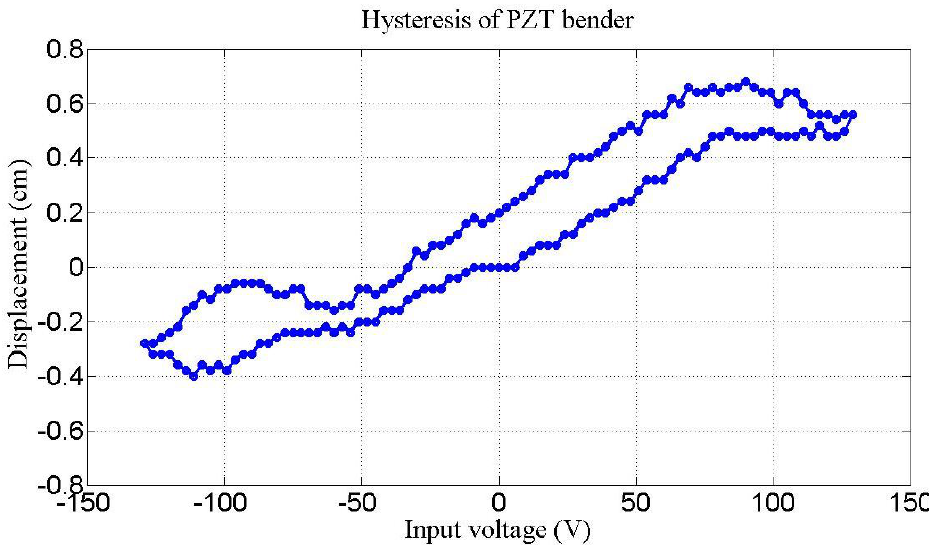
Figure 9. Deflection curve of hysteresis loop in a bimorph bender with the applied voltage swing from  125 V.